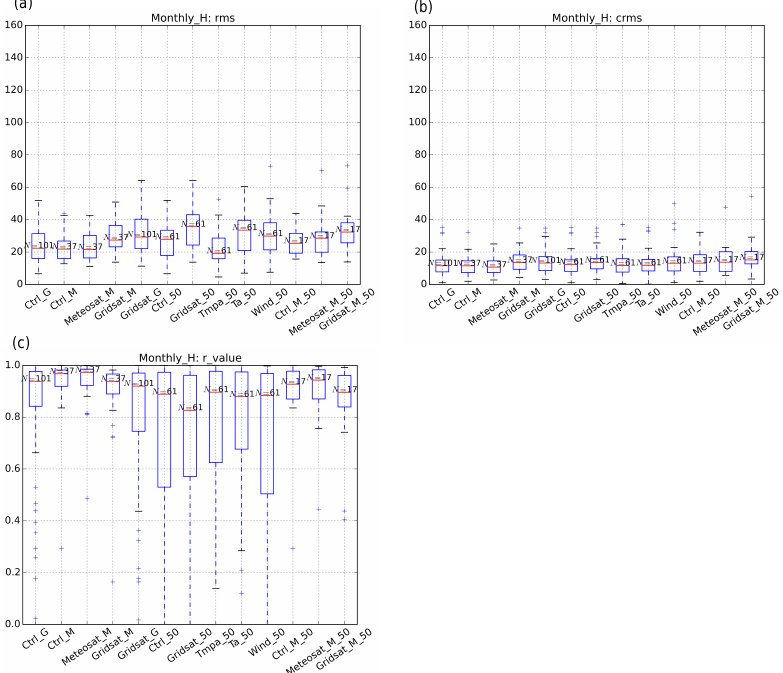
Figure D6. Similar error statistic for sensible heat flux like in Fig. 10 but for monthly values: (a) RMSD, (b) cRMSD, (c) correlation